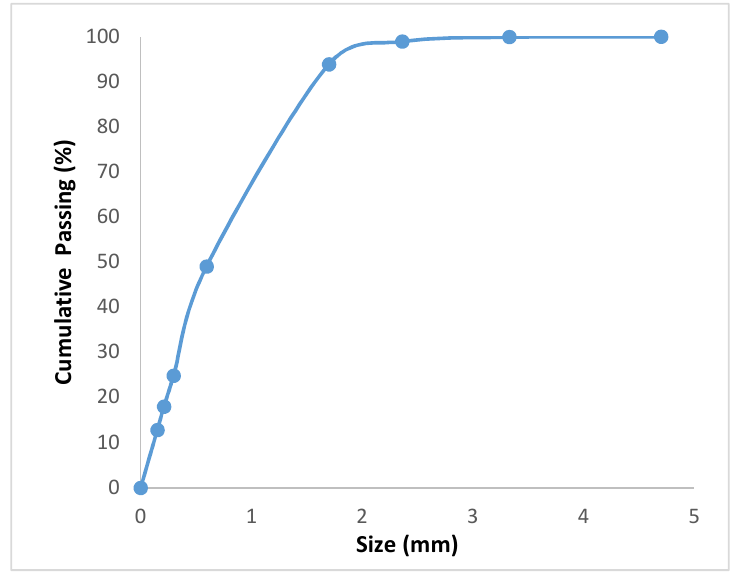
Figure 2. Cumulative particle size distribution of the demagnetized and comminuted sample.